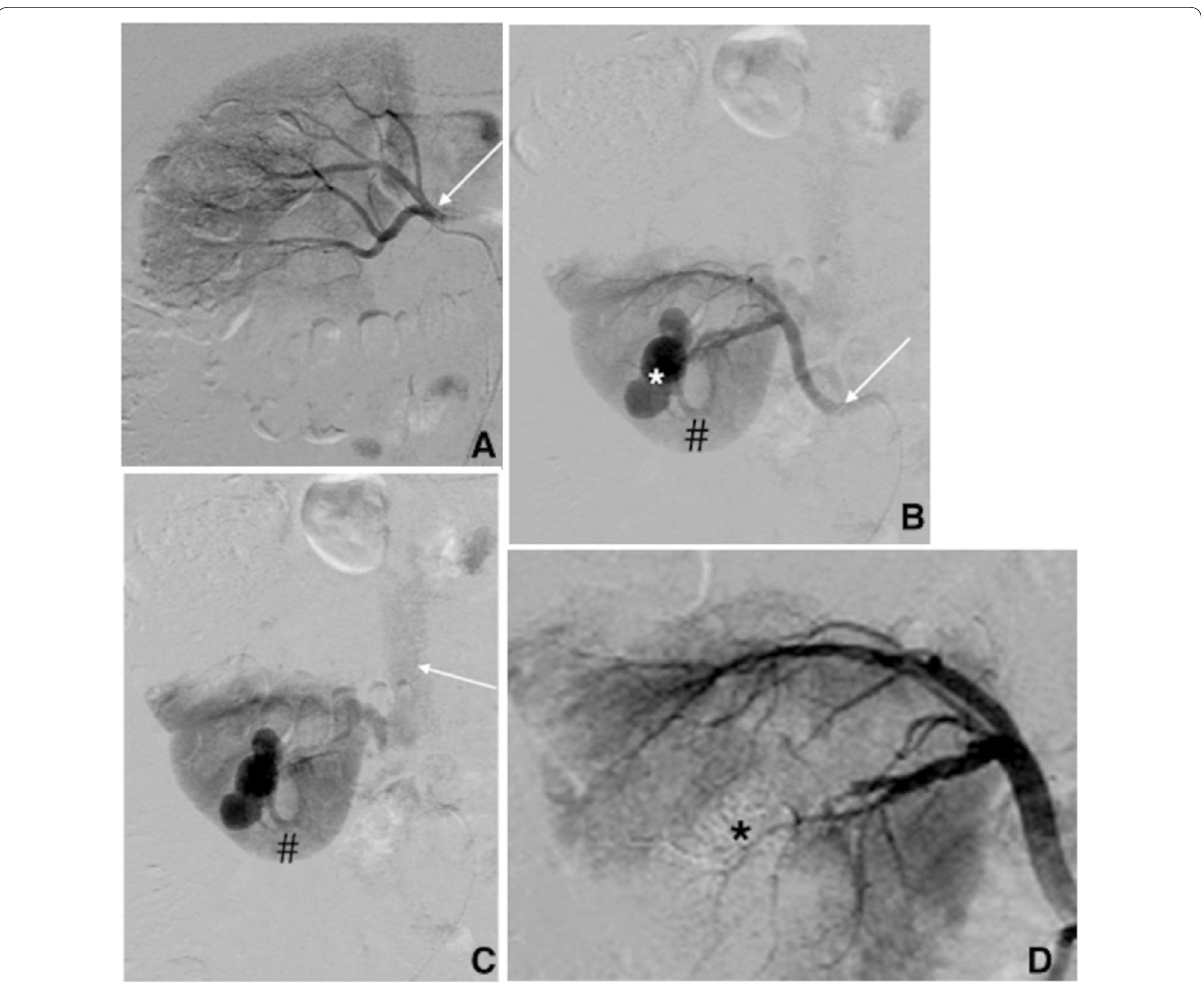
Fig. 1 Catheter angiography showing right renal artery supplying upper and mid-pole of right kidney (arrow in Panel A ) and an accessory renal artery (arrow in Panel B ) supplying lower-pole of right kidney with a multi-lobulated pseudo-aneurysm (* in Panel B ) arising from it. Early draining vein (# in Panel B ) on arterial phase, confirmed to be an AVF (arterio-venous fistula) on venous phase (# in Panel C ) with contrast draining into IVC (arrow in Panel C ). Post-embolization angiogram showing glue-cast (* in Panel D ) without any residual